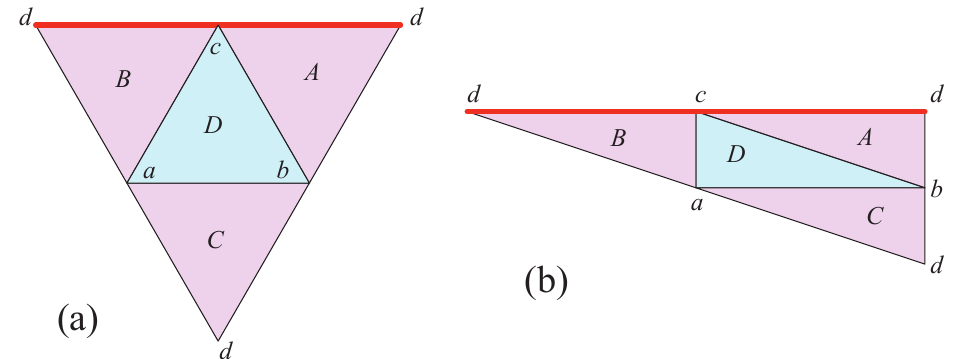
Figure 2. ( a , b ) Unfoldings of two isosceles tetrahedra. Quasigeodesic Q (red) is a degenerate doubling of edge dc